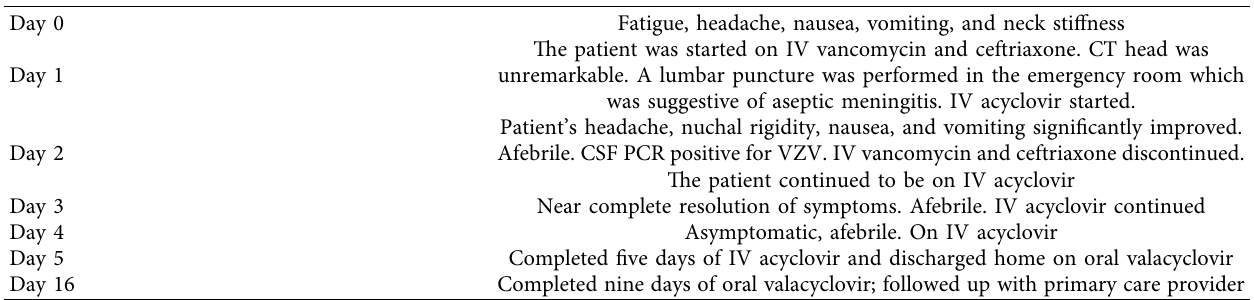
Table 4: Timeline of clinical